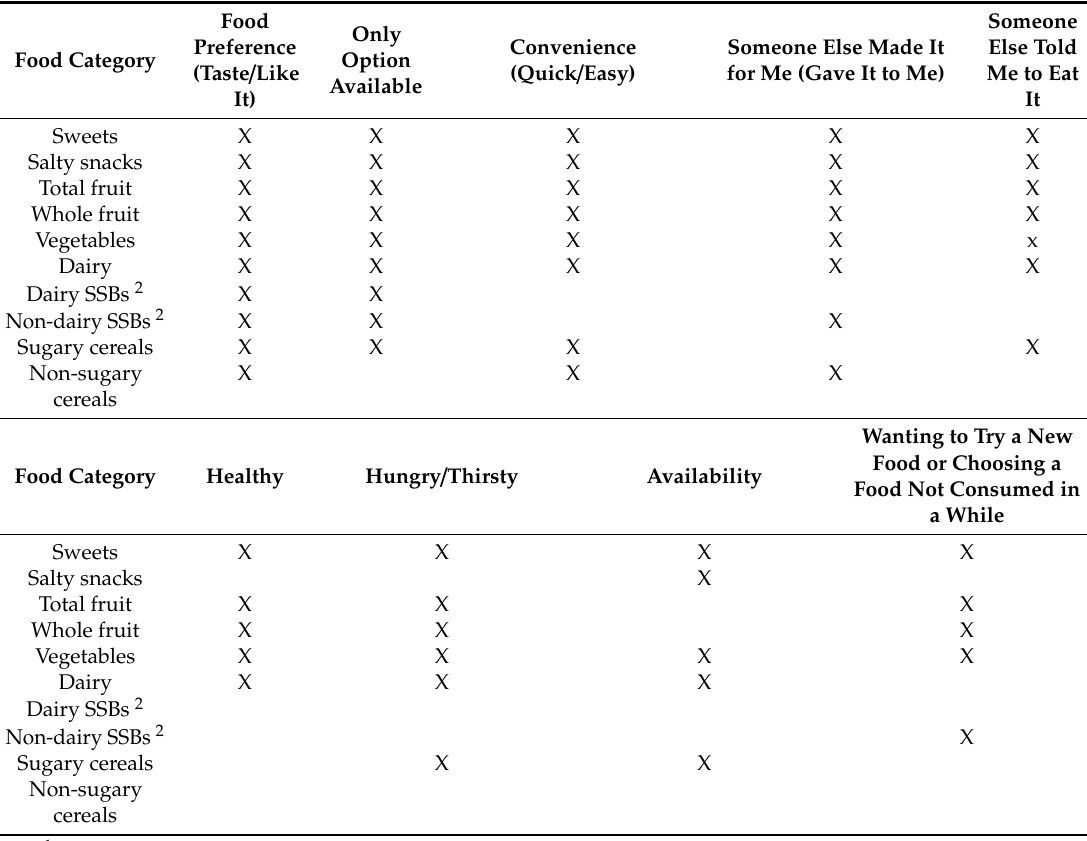
Table 5. Reasons for choosing foods at independent eating occasions (iEOs) by food category among participants (10–13 years) 1